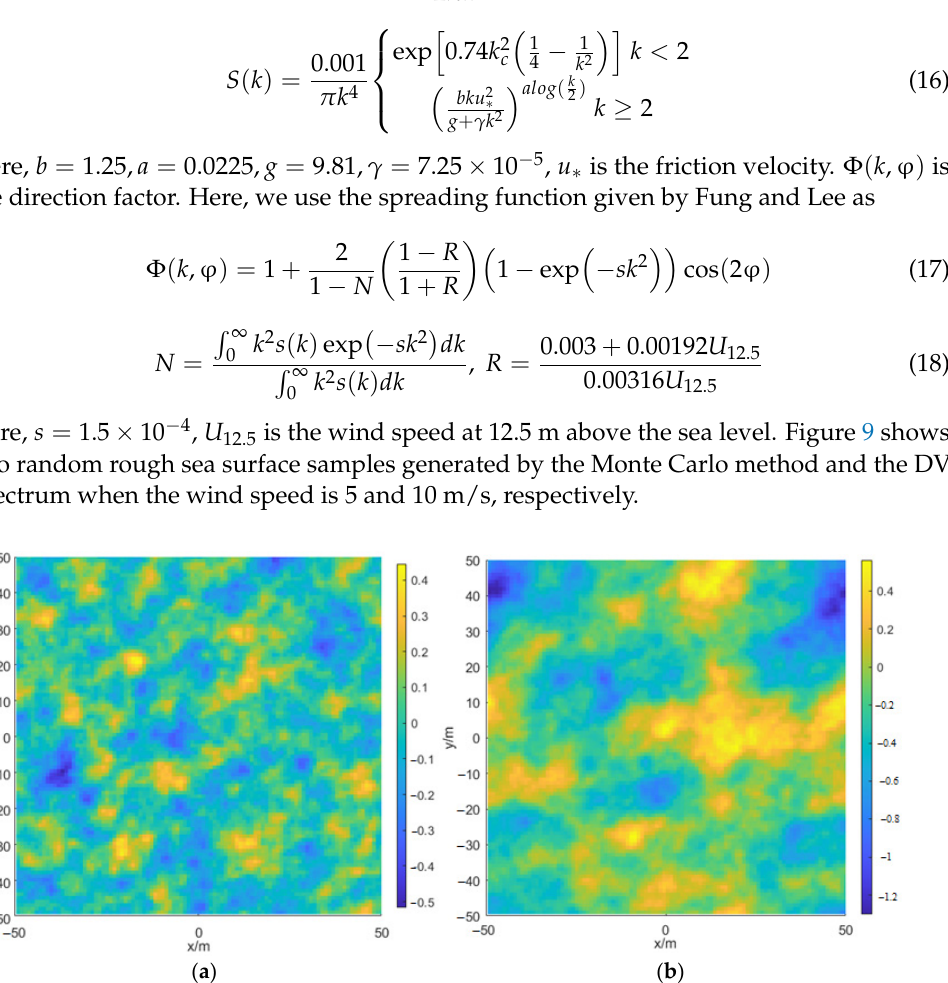
Figure 9. Rough sea surface sample with different wind speeds at 12.5 m above sea level. ( a ) 𝑈 (cid:2869)(cid:2870).(cid:2873) (cid:3404) 5 m/s ; ( b ) 𝑈 (cid:2869)(cid:2870).(cid:2873) (cid:3404) 10 m/s . ( a ) U = 5 m/s; ( b ) U = 10 12.5 12.5